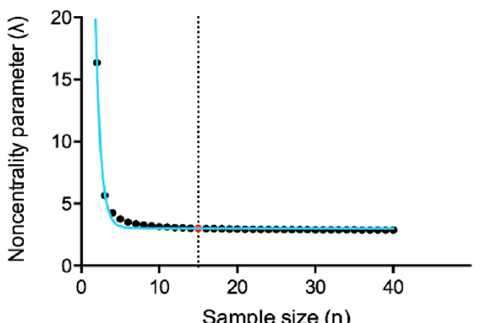
Figure 3. Plateau value (reported as a red dot) threshold (reported as a dotted vertical line) of λ computed for sample sizes up to forty subjects. Each sample size is represented by a black dot. In blue the exponential decay function curve of the previously computed λ .